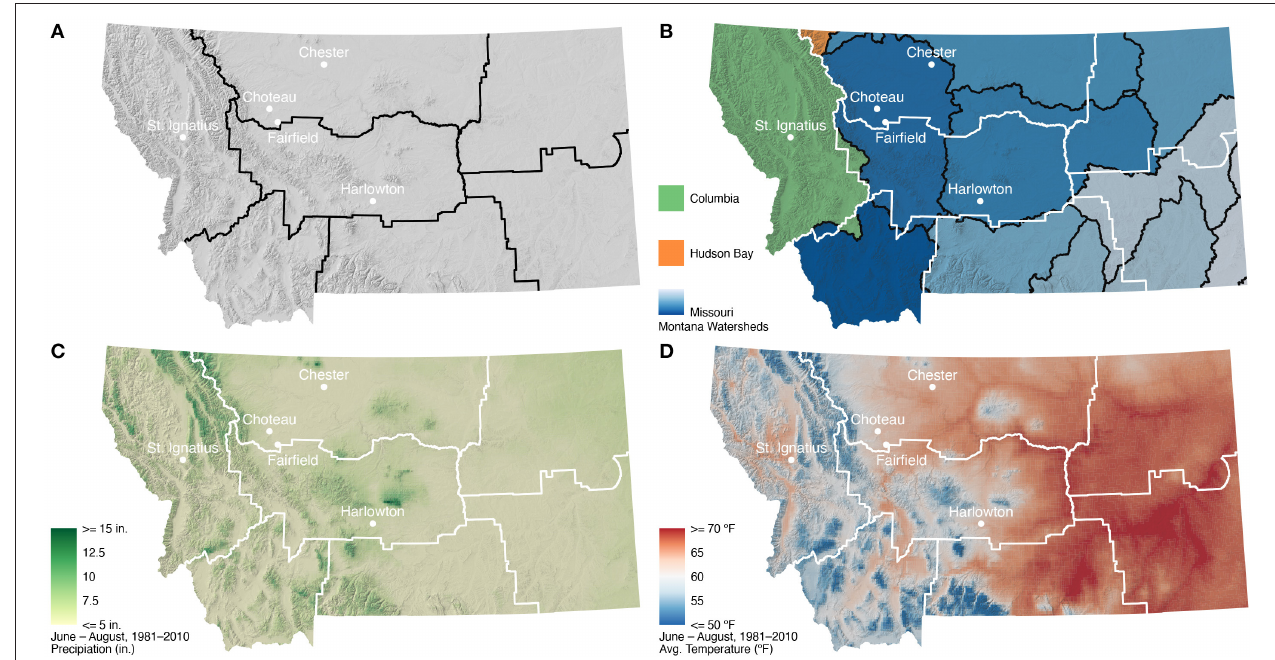
FIGURE 1 | Map showing seven climate divisions as defined by NOAA’s Climate Prediction Center (A) , boundaries of Montana watersheds (B) , and average precipitation (C) and average temperature (D) June-Aug 1981–2010. Map also indicates the location of the five study sites.